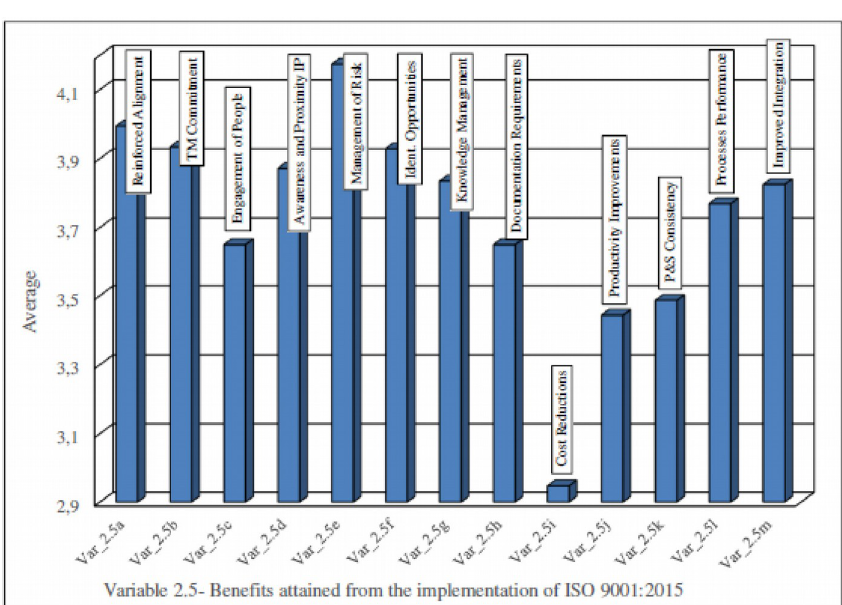
Figure 3. Average values of the benefits attained by the organization from the implementation of the new ISO 9001:2015 requirements